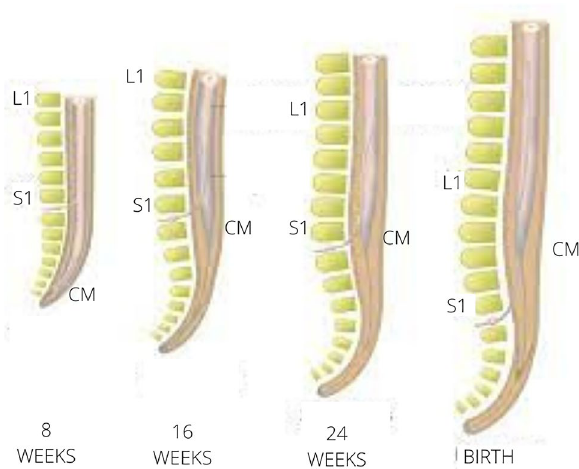
Figure 1. Ascent of the conus medullaris. Illustrations demonstrating progressive ascent of the conus medullaris (CM) during embryogenesis (8, 16 and 24 weeks) until birth and its relations to L1 and S1. Adapted from book “Cem milhões de neurônios”, Roberto